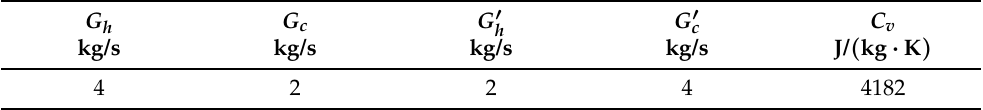
Table 2. Mass flow rates of two symmetrical